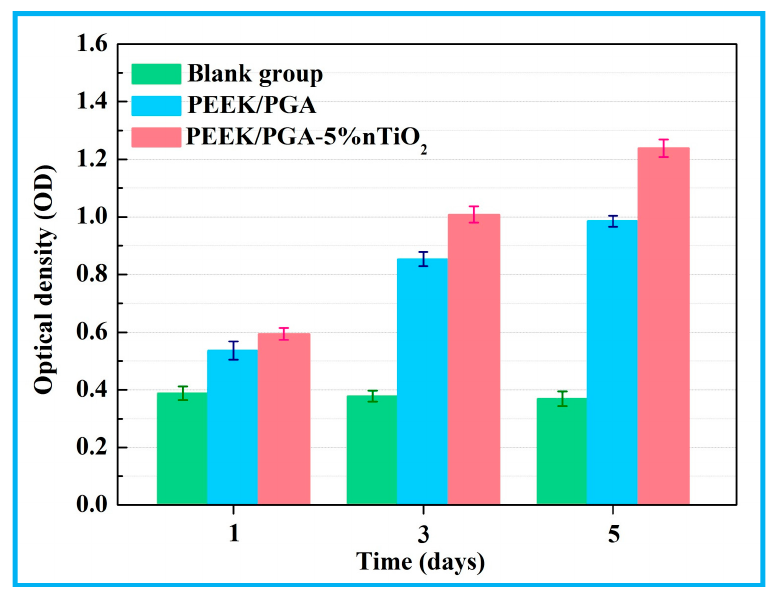
Figure 12. Proliferation of MG ‐ 63 cells on PEEK/PGA ‐ 5%nTiO 2 and PEEK/PGA scaffolds after culture for 1, 3, and 5 days.